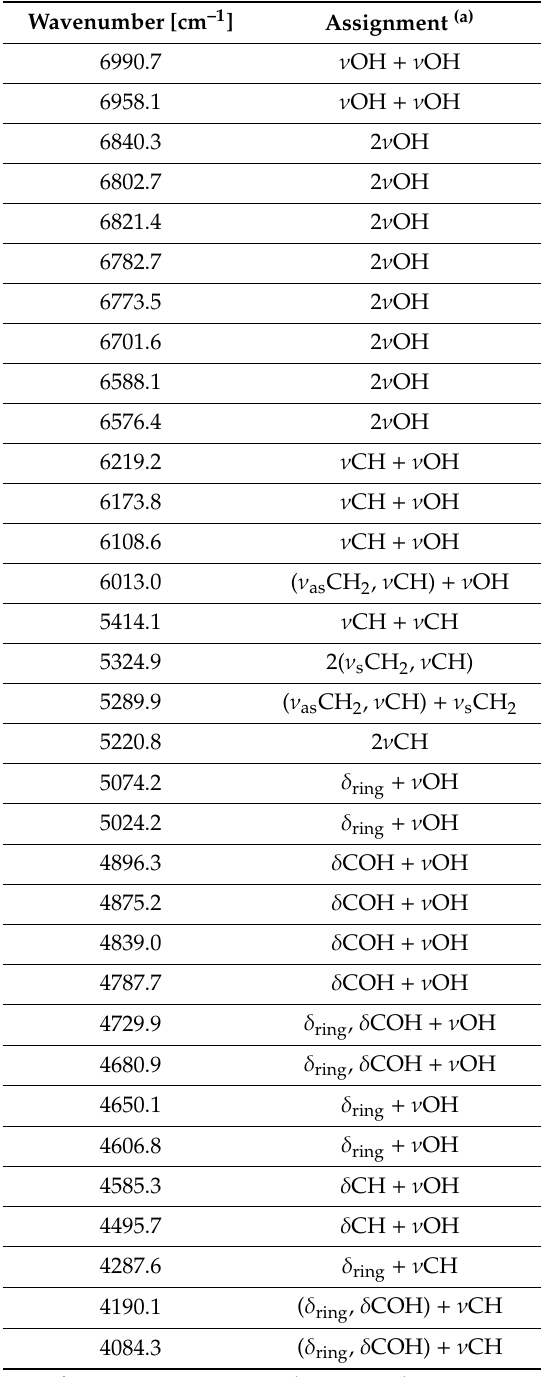
Table 4. Assignments of NIR bands of cyanidin-3-O-glucoside based on quantum chemical calculations. Wavenumber [cm –1